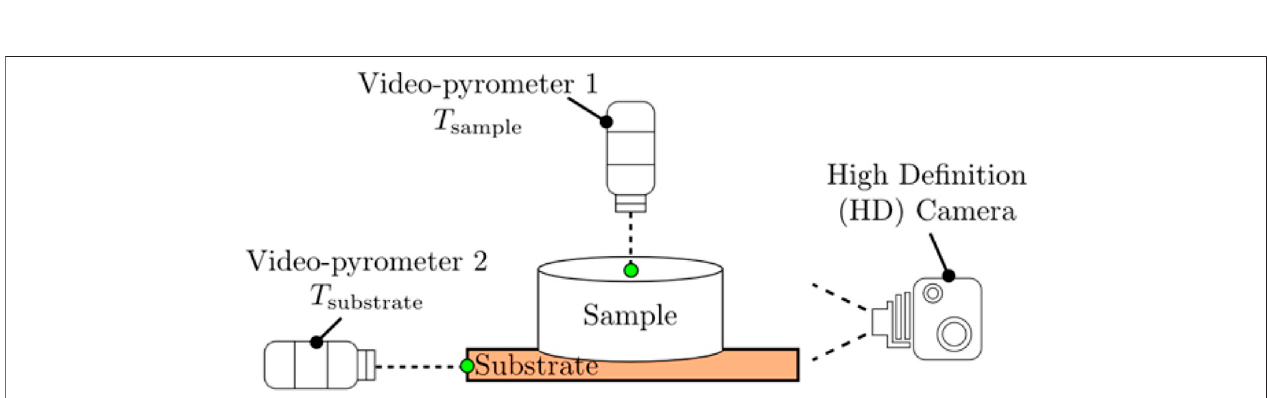
FIGURE 9 | Visual Polythermal Analysis (VPA) imaging system of VITI.